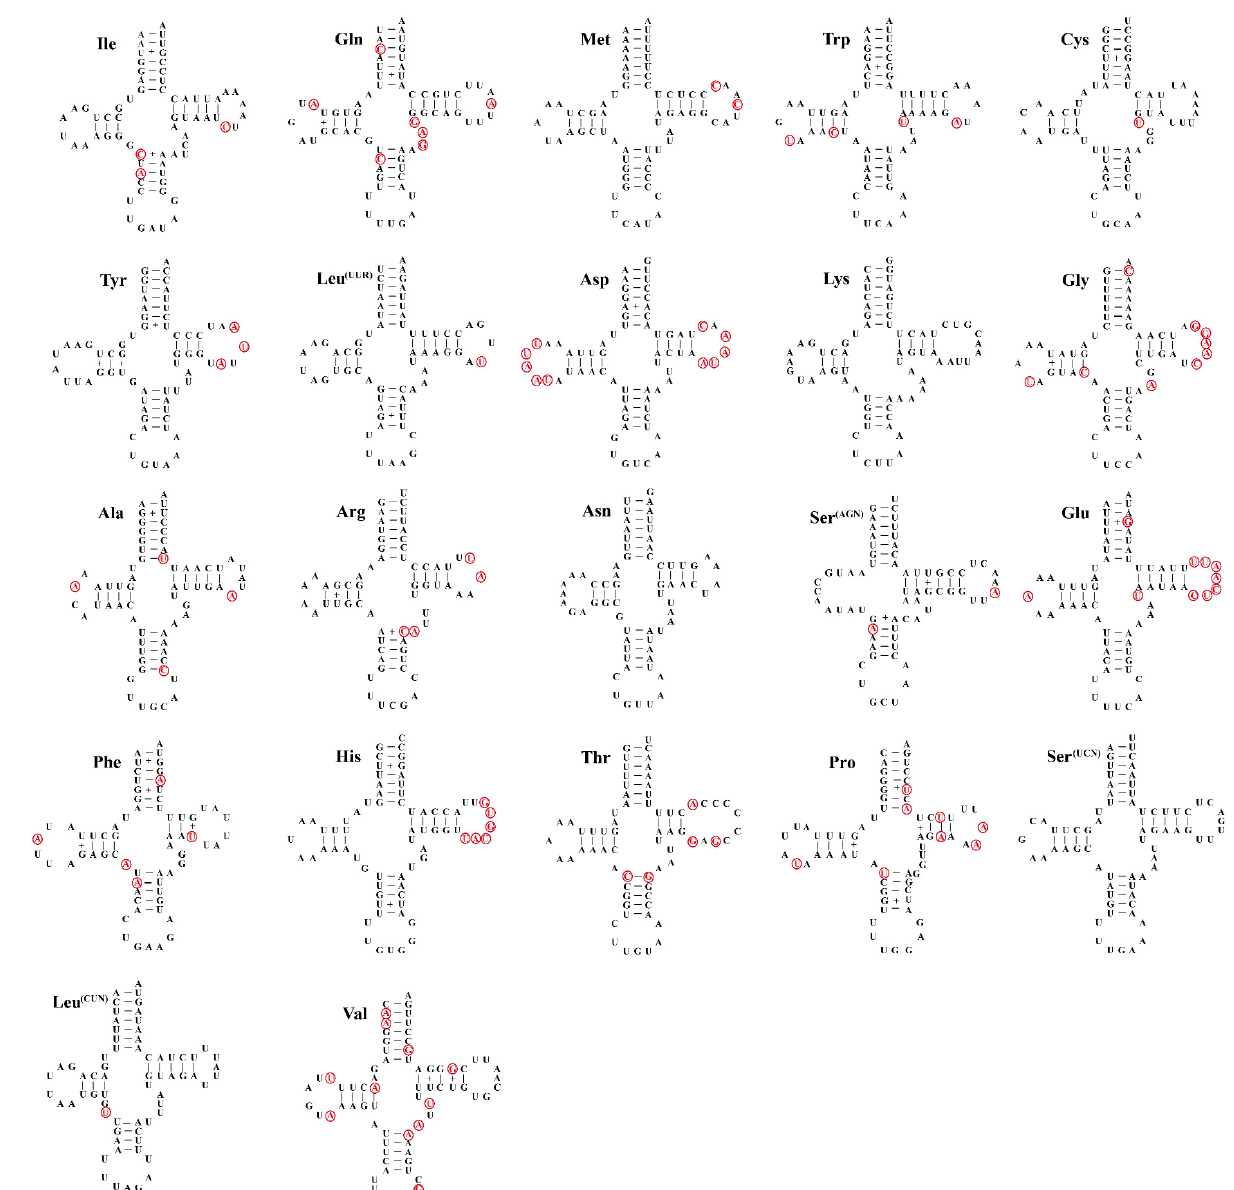
Figure 3. Secondary structures of 22 tRNAs identified in the mitogenome of F. sunanensis . All of the genes are shown in order of occurrence. Watson–Crick base pairings and mismatches are represented by dashes (-) and pluses (+). The conserved and variable sites among the other 4 species of grasshoppers are indicated with black and red hollow circles,